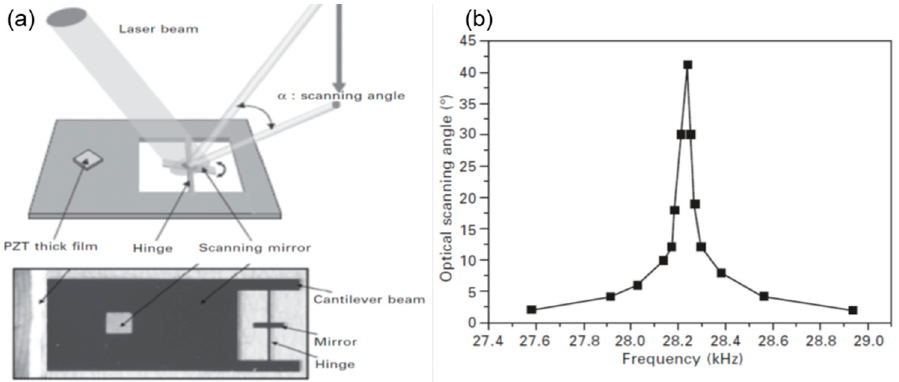
Figure 27. ( a ) Schematic of a micro-scanner based on metal structure and Lamb wave resonation for raster-scanning laser displays. ( b ) Frequency-dependent optical scanning angle of an optical micro scanner driven by a PZT thick film under a driving voltage of 60 V [74]. © Copyright 2005, Jpn. J. Appl. Phys.